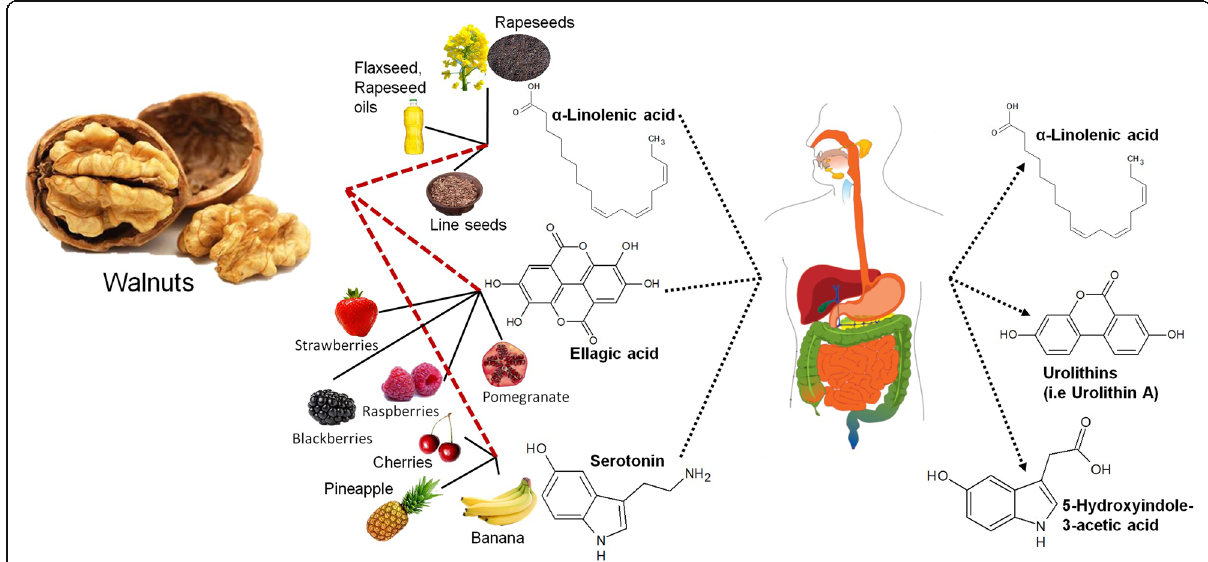
Fig. 2 Schematic diagram of combining medium-specific single biomarkers to create a more specific multi-metabolite biomarker